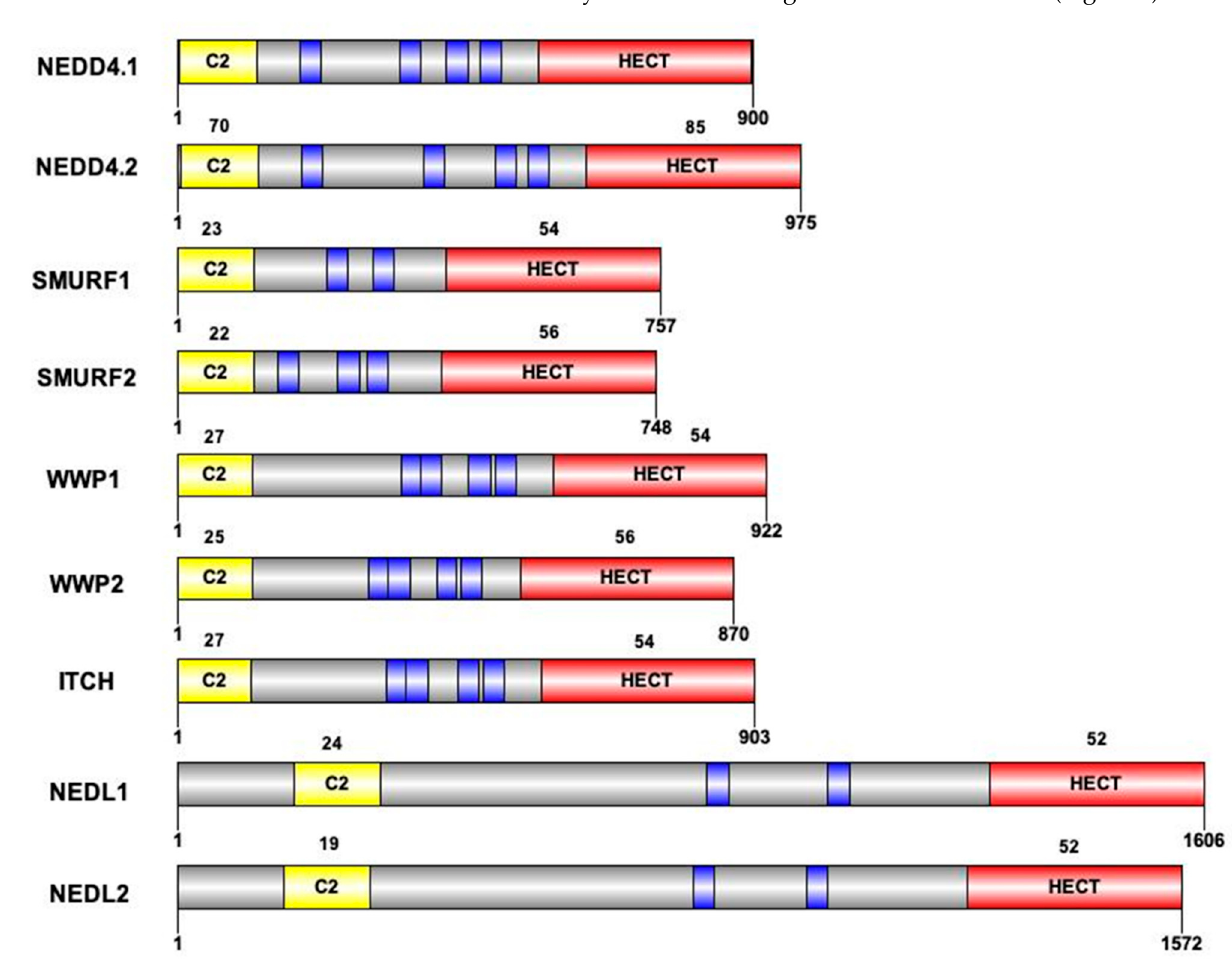
Figure 2. Structure of the 9 HECT E3 ligases of the NEDD4 subfamily. Protein size and domain conservation expressed as percentage of conservation compared to NEDD4.1 protein. Sequence of the nine members (UniprotKB) and identity percentage are obtained by alignment (MUSCLE) for the C2 and the HECT domains. Blue boxes represent the WW domains of each protein. Due to differences in the number of WW domains across proteins, identity percentage is not calculated for these domains.